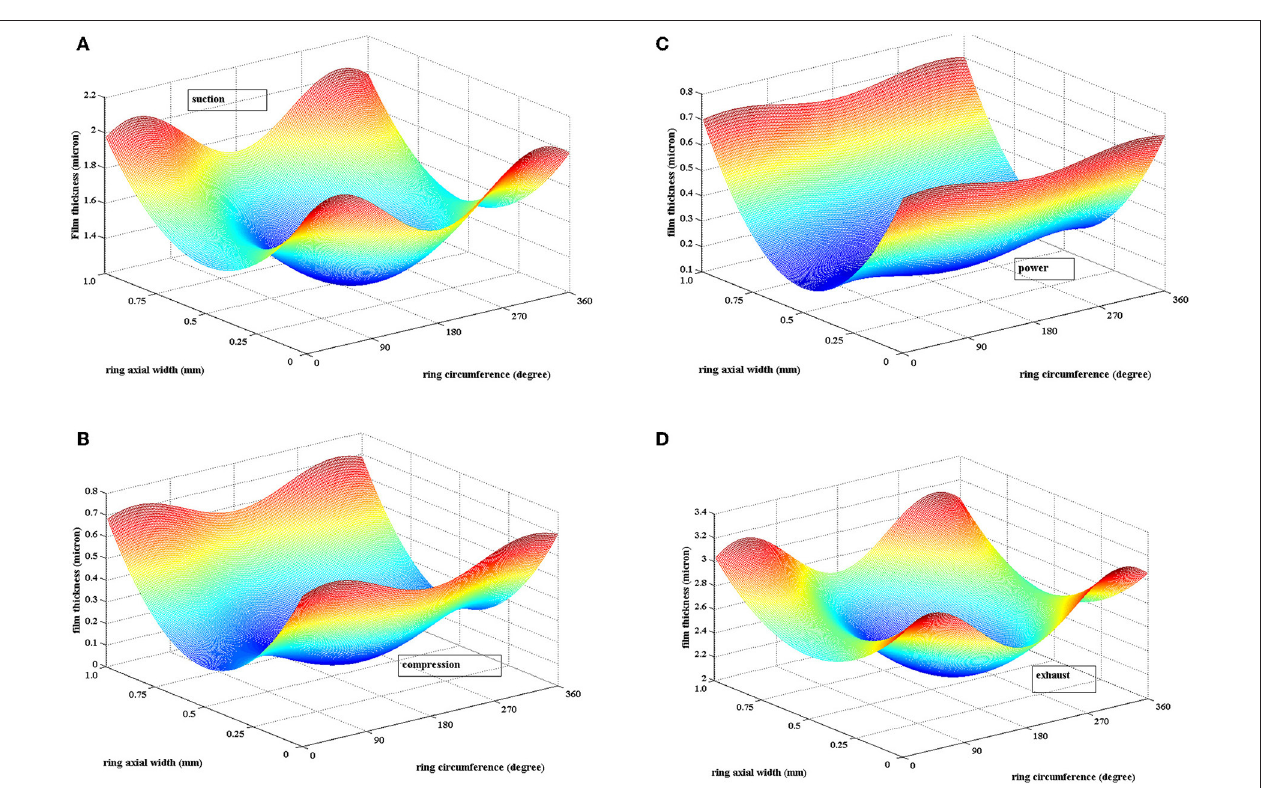
FIGURE 7 | Three dimensional film thickness: (A) Suction stroke, (B) Compression stroke, (C) Power stroke, and (D) exhaust stroke. (A) Suction stroke ( θ c P com 5 bar, η 0 0.004Pa.s, U = = 0.004Pa.s, U 5 m/s). (D) Exhaust stroke ( θ c =